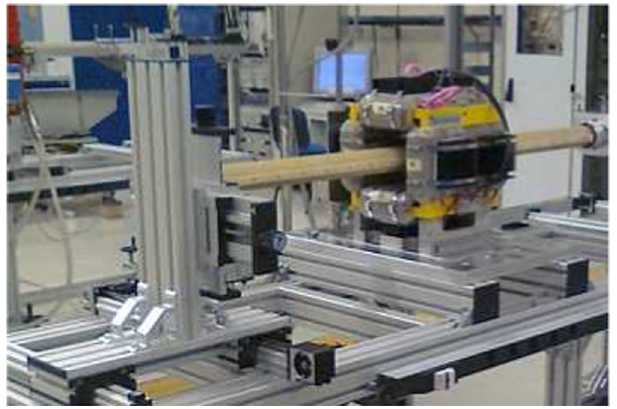
FIG. 14. Picture of a conventional H = V corrector magnet used to measure remanent field and field quality at very low